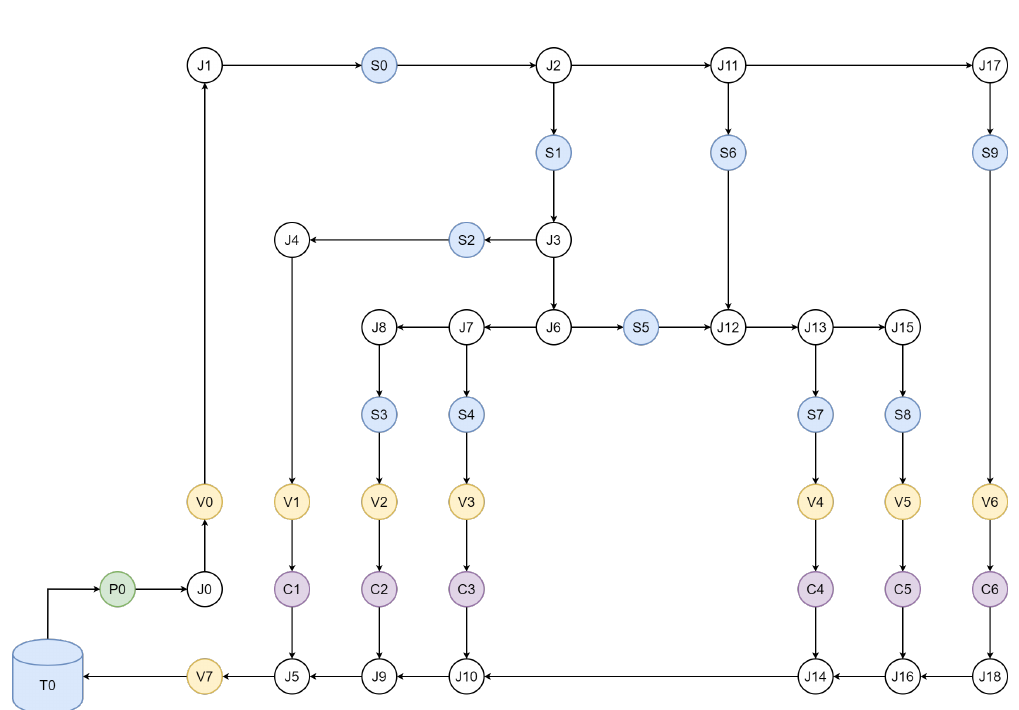
Figure 3. Experimental model